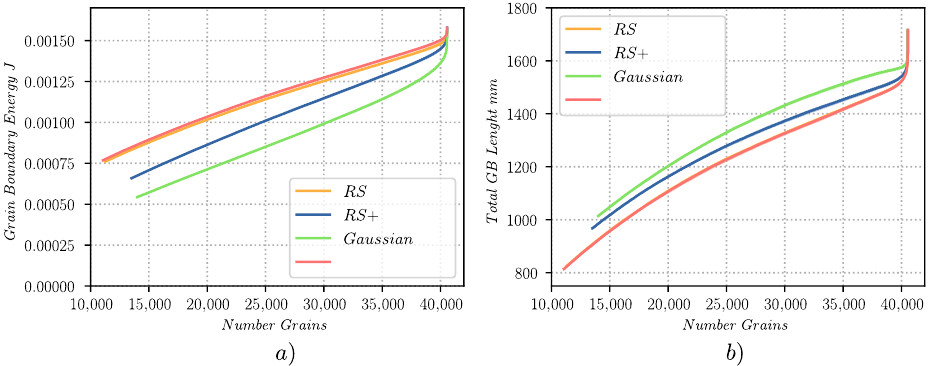
Figure 14. Evolution of different parameters as a function of the number of grains, for the 2D heterogeneous GG test case simulated with the TRM model: ( a ) total grain boundary energy E Γ and ( b ) total lenght of GBs.